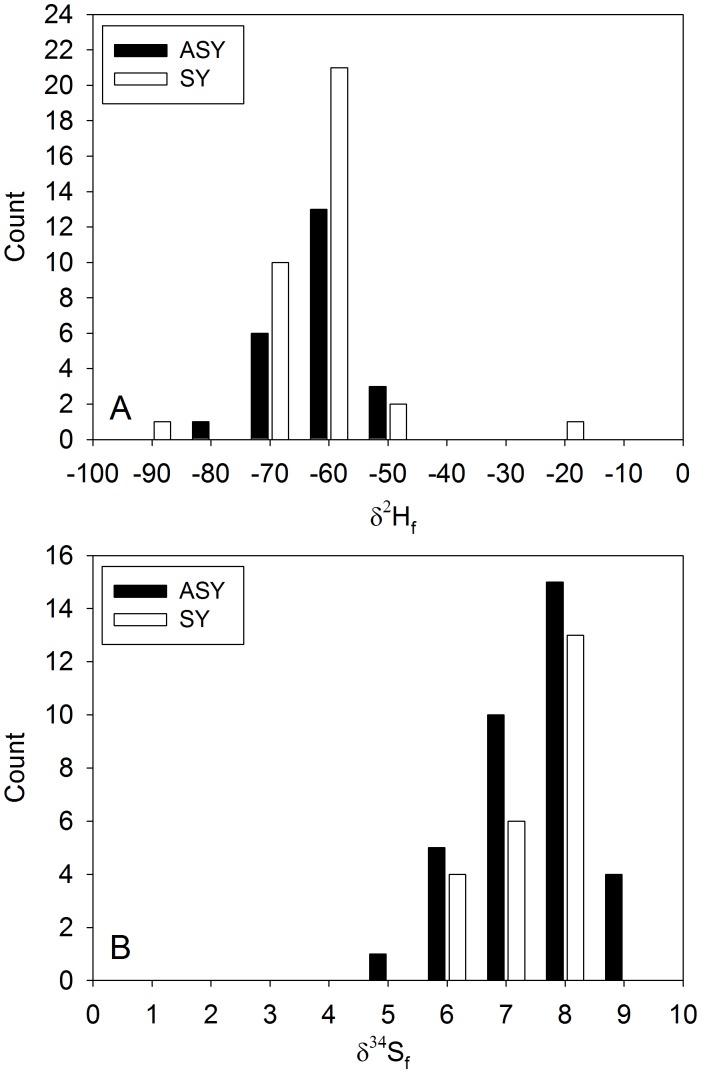
Histograms of δ2Hf (A) and δ34Sf (B) from returning ASY (n = 23) and SY (n = 35) males breeding in the Black Brook district, New Brunswick, in 2010.